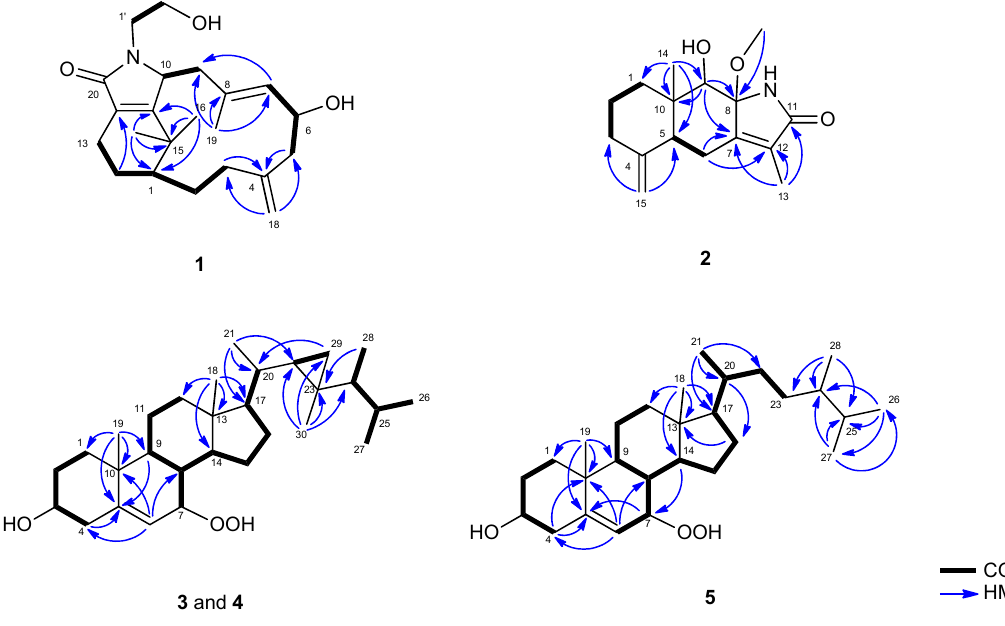
Figure 2. Selected 1 H– 1 H COSY and HMBC correlations of 1 – 5 .